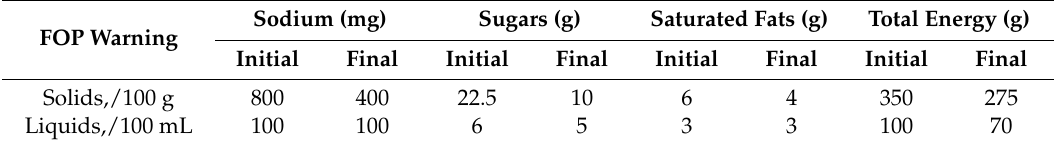
Table 1. Initial and final phases front-of-package (FOP) warning label limits of law